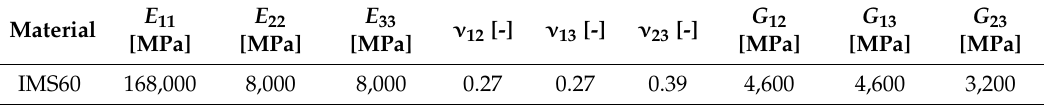
Figure 9. 1/8-model of the pin-strap contact problem used for the FEA. The picture on the right illustrates where the measurements of the relative tangential slip (CSLIP2) between the pin and the strap in the fibre direction as well as the local stresses in the fibre direction ( σ 1 ) were taken.